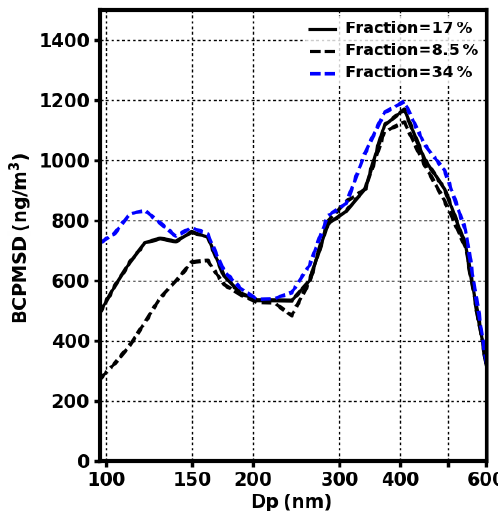
Figure 6. The derived BCPMSD by using different constant BC- containing particle fractions. The solid black line represents the re- sult derived from a fraction of 17%. The dashed black line and blue line show the results derived from fractions of 8.5% and 34% , re-